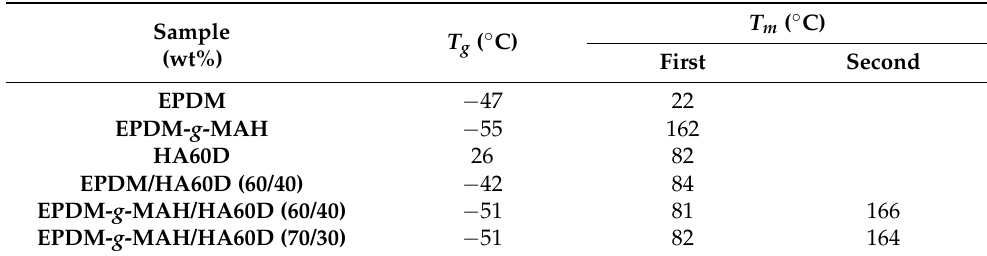
Figure 5. The DSC thermograms of the pristine compounds and the EPDM/HA60D, EPDM- g - MAH/HA60D vulcanizates. Table 2. The thermal properties of pure EPDM, EPDM- g -MAH, HA60D, and the EPDM/HA60D, EPDM- g -MAH/HA60D